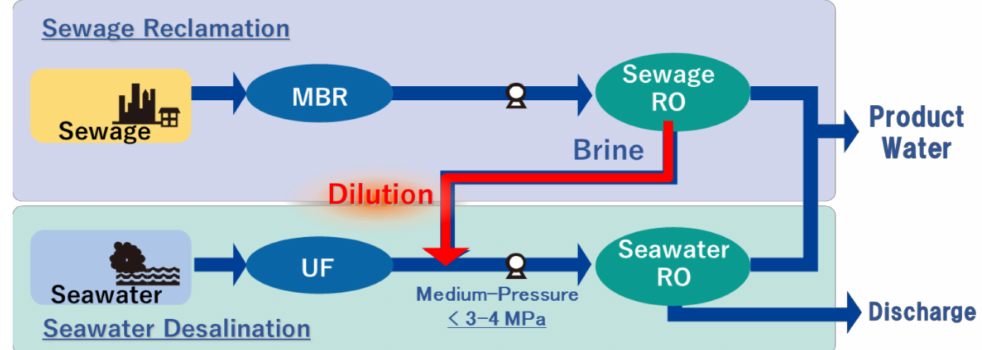
Figure 8. The schematic flow configuration of the integrated system of sewage reclamation and seawater desalination at “Water Plaza” in Kitakyushu, Japan. RO brine of sewage reclamation system, which is normally wasted, is reused for seawater dilution to reduce the osmotic pressure of feed water of the SWRO desalination system. It is expected that a more than 30% reduction of energy consumption is achieved in seawater desalination